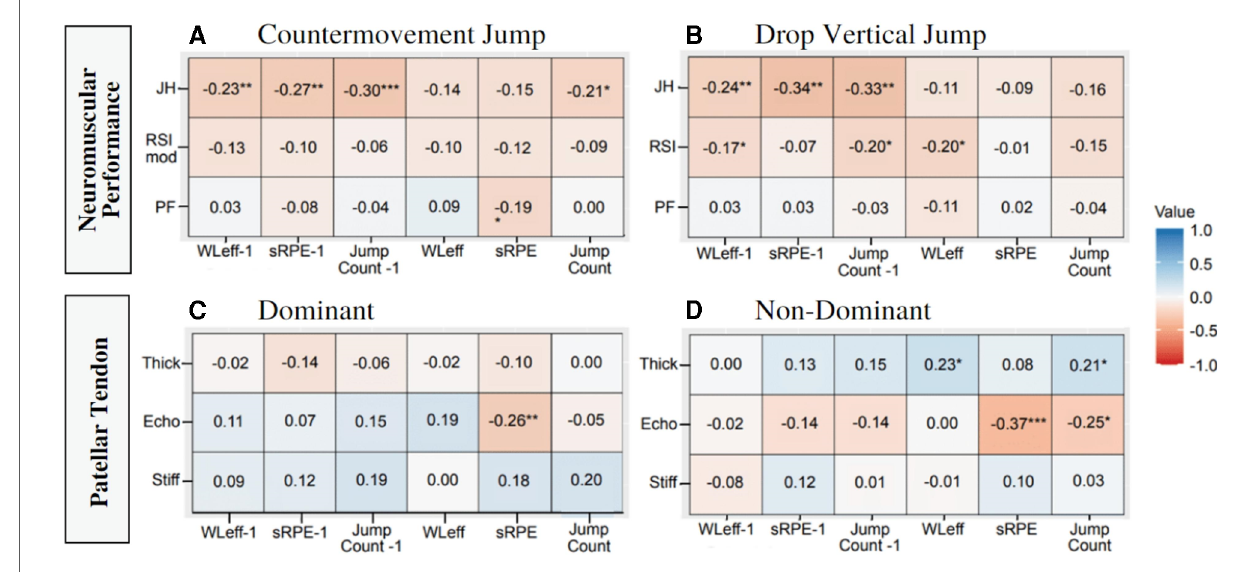
FIGURE 5 Pearson ’ s correlation coef fi cient matrix between ( A ) countermovement jump and workload, ( B ) drop vertical jump and workload, ( C ) dominant patellar tendon and workload, ( D ) non-dominant patellar tendon and workload. * p <0.05, ** p <0.01, *** p <0.001. sRPE, session rating of perceived exertion; WLeff, workload ef fi ciency, − 1 indicates time-lagged